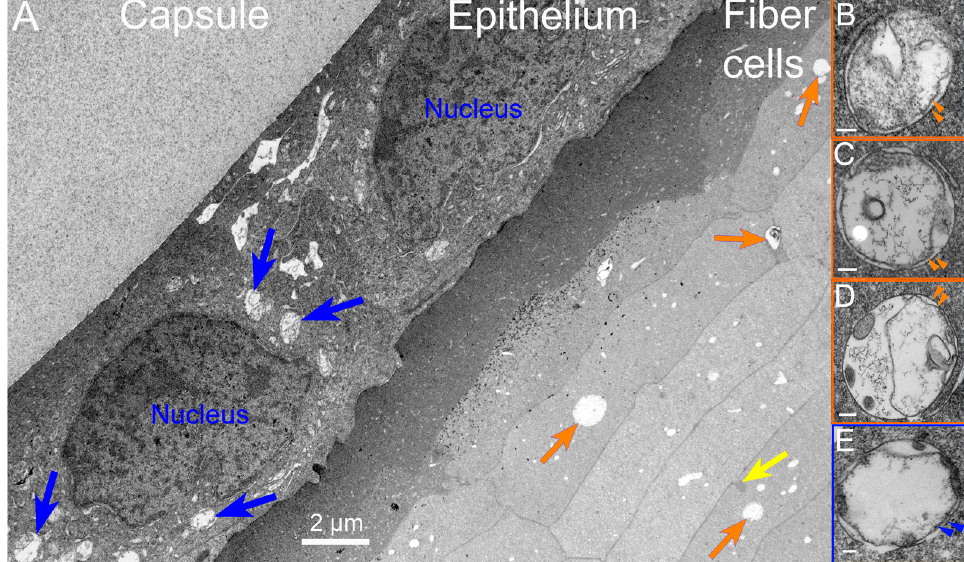
Figure 2. Low-magnification transmission electron microscopy (TEM) overview of the outer cortex of an adult macaque monkey lens. ( A ) This image, taken near the equatorial plane, displays the capsule, which is nearly homogeneous (about 10 µm thick), and the epithelium (about 7 µm thick), which has a very smooth interface with the capsule. The epithelium contains two prominent nuclei and numerous organelles, including autophagic vesicles (blue arrows) showing the classic double-membrane profile and heterogeneous contents. A narrow band of elongating fiber cells is generally more darkly stained, with the cells having irregular cross-sections that blend into classical fiber cells, which form radial cell columns and have flattened hexagonal shapes (about 2 × 10 µm). Several autophagic vesicles are labeled (orange arrows), and one ball-and-socket interdigitation (yellow arrow) typical of this region is about 0.5 µm long. ( B – E ) Insets are examples of autophagosomes from different regions in the same sample to illustrate the double-membrane structures (double arrowheads) at high magnification. The scale bars in the insets are 100 nm. ( B ) Autophagic vesicle shows degradation of cytoplasmic material in the space between two large irregular vesicles. A small segment of ER appears just outside the autophagic vesicle (upper left). ( C ) Extensive protein degradation in the center leaves a typical reticulated network. A vesicular structure with three thin lipid bilayers is darkly stained and next to a low-density vesicle-like circular profile, probably representing material lost during processing, which illustrates that the uniform background staining in all the examples is preserved fluid after degradation by hydrolytic enzymes. A segment of ER is preserved (upper right). ( D ) A variety of vesicular structures are being degraded along with protein, leaving reticulated patterns. A segment of ER is preserved (lower right). ( E ) Degradation has proceeded in this epithelial autophagic vesicle interior, leaving a few fragments extending into the preserved fluid.